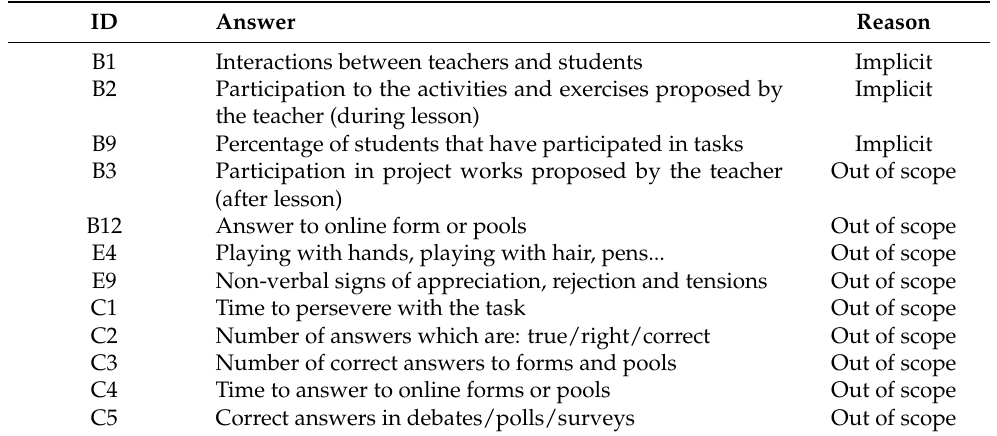
Table 4. Answers identified as either implicit or out of scope.